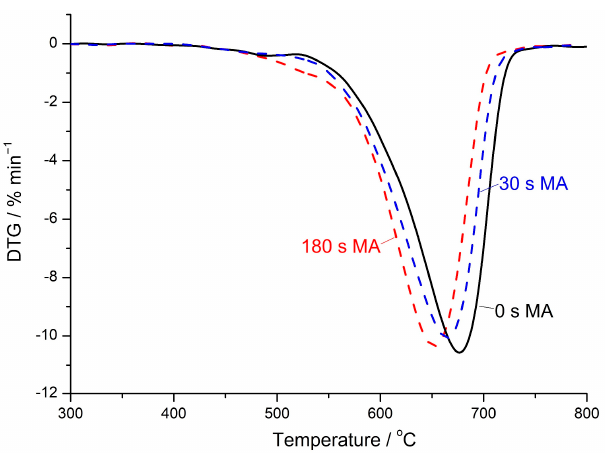
Figure 12. Differential thermogravimetric (DTG) curves of the raw magnesite (0 s MA) and magnesite mechanically activated for 30 s and 180 s.